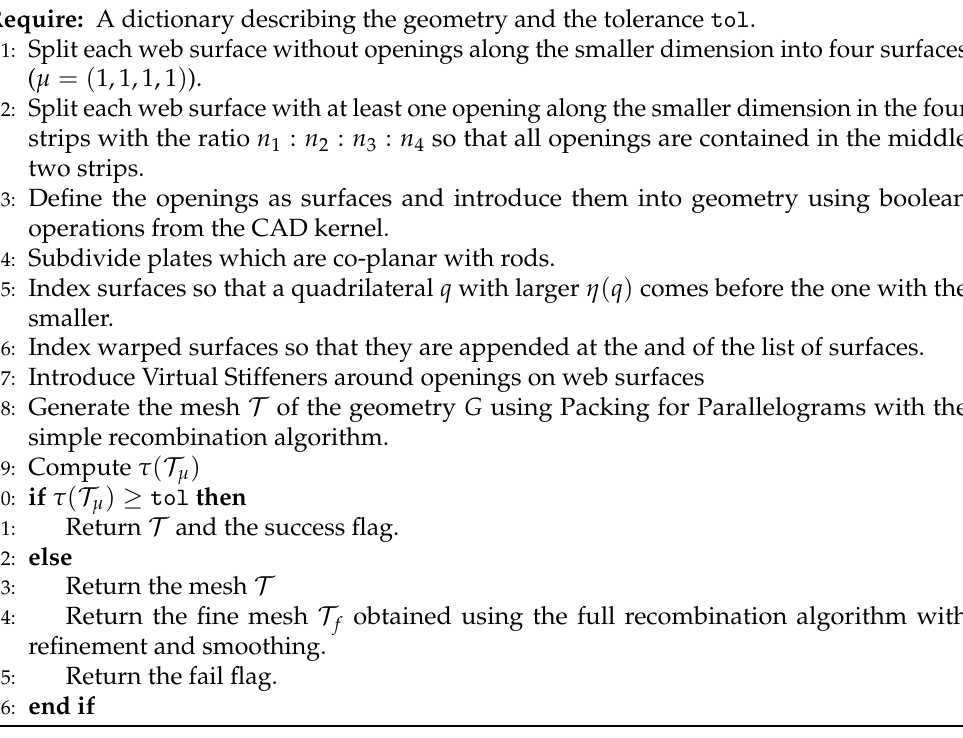
Algorithm 1 Preconditioning the Packing for Parallelograms algorithm from [14]